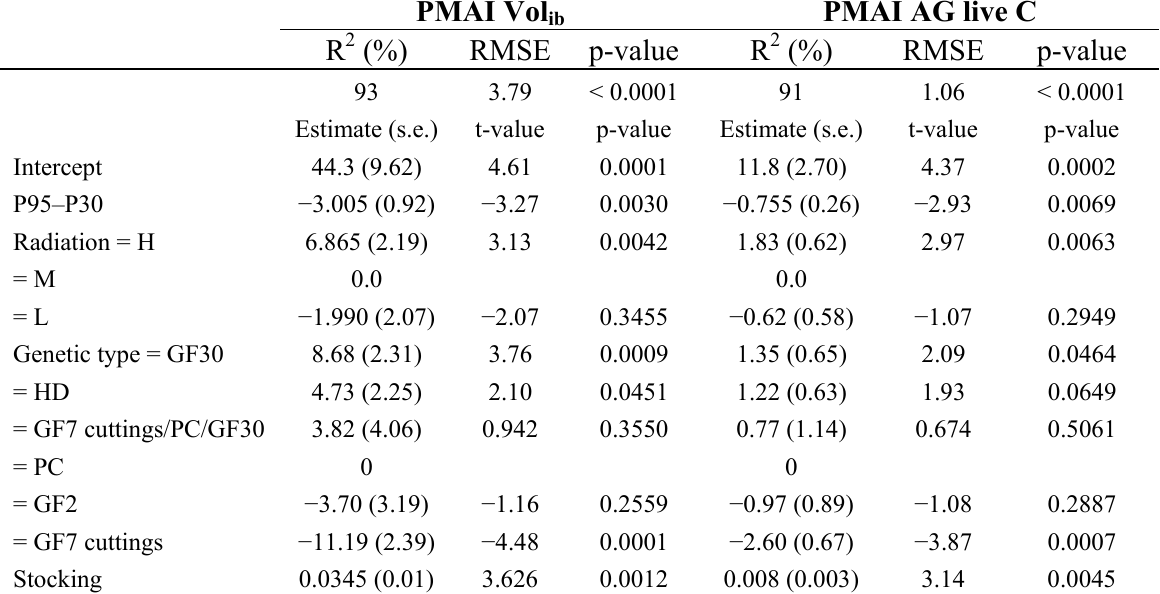
Table 9. Multiple regression model coefficients for estimating PMAI in stem volume increment and carbon sequestration from age 9 to 13 years, using 2010 LiDAR percentile heights (P95–P30), aspect, genetic type, and stocking per plot for 36 plots in Puruki